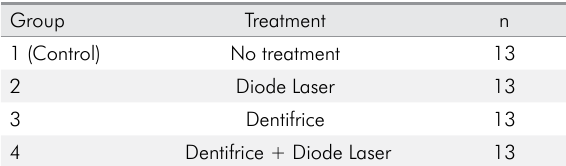
Table 1. Experimental